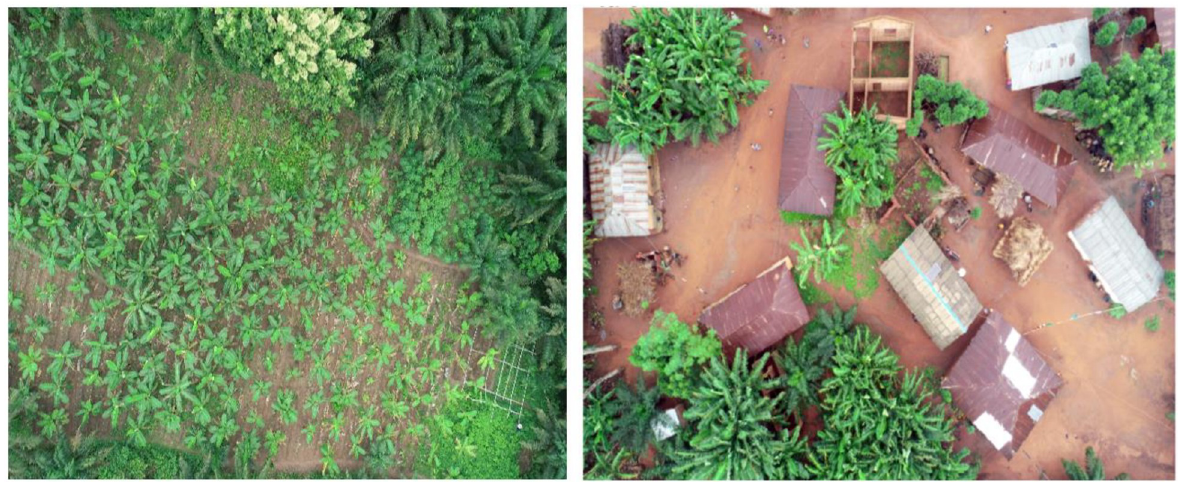
Fig 3. Photo took by the UAV during flight missions. (left) Open gardens. (Right) backyard gardens.